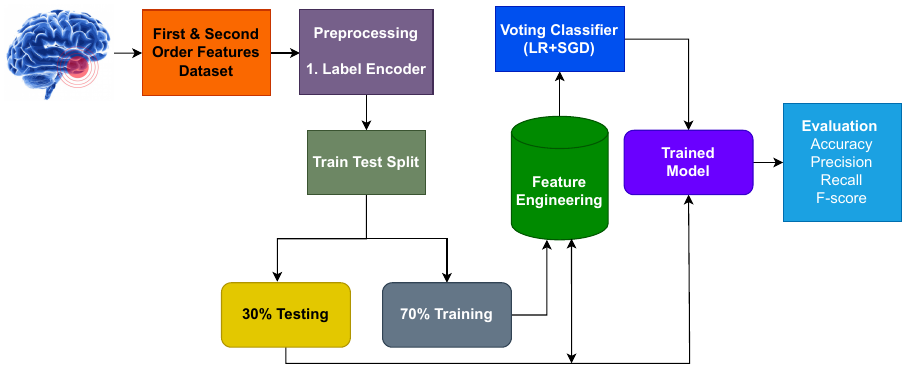
Figure 2. workflow diagram of the proposed voting classifier (LR+SGD)